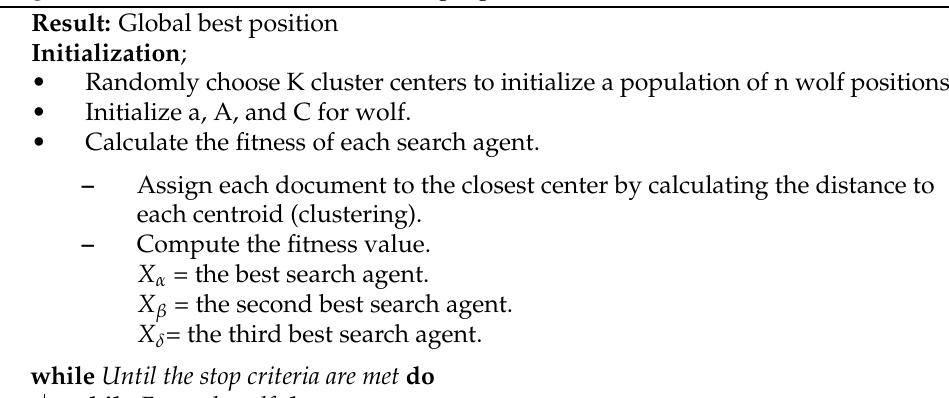
Algorithm 4: GWO document clustering algorithm